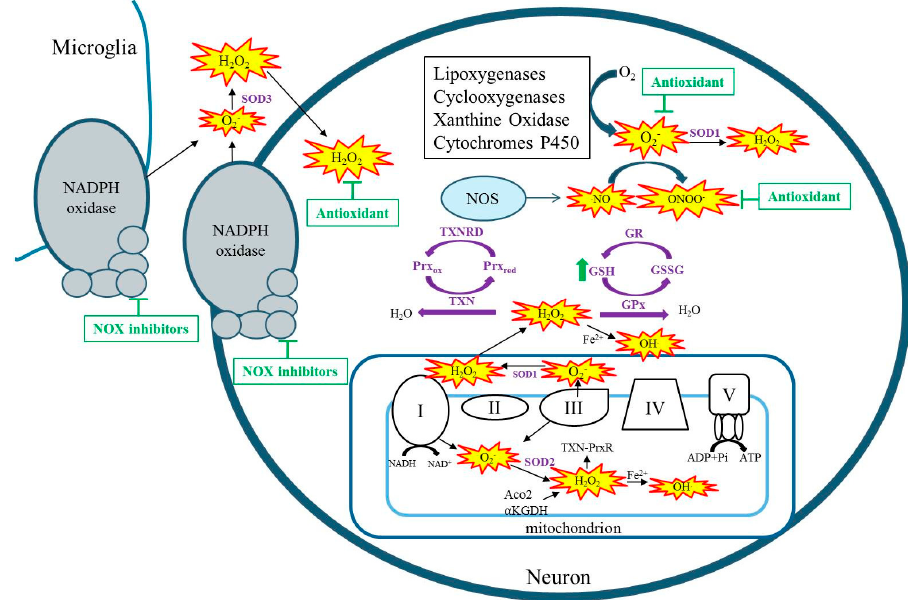
Figure 1. Cellular sources of reactive species (RS). RSs are denoted by yellow starbursts.Antioxidant systems and their detoxification of RS are denoted in purple and purple arrows, respectively. Therapeutic strategies for detoxification of seizure-induced RSS are denoted by green arrows, indicating elevating GSH or t-bars indicating inhibition by antioxidants or NOX inhibitors. NOS: nitric oxide synthase; GSH: reduced glutathione; GR: Glutathione reductase; GSSG: oxidized glutathione; GPx: Glutathione peroxidase; SOD: superoxide dismutase; TXN: thioredoxin; TXNRD: thioredoxin reductase; Prx ox : peroxiredoxin oxidized; Prx red : peroxiredoxin reduced; Aco2: aconitase; Α -KGDH: alpha-ketoglutarate dehydrogenase.